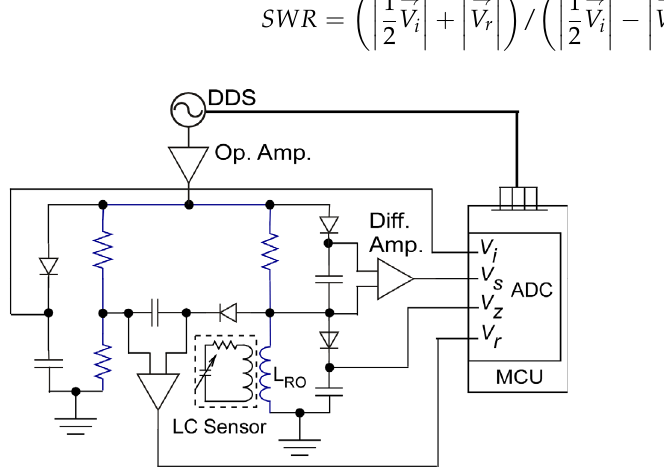
Figure 6. Circuit schematic of readout node on Readout PCB.